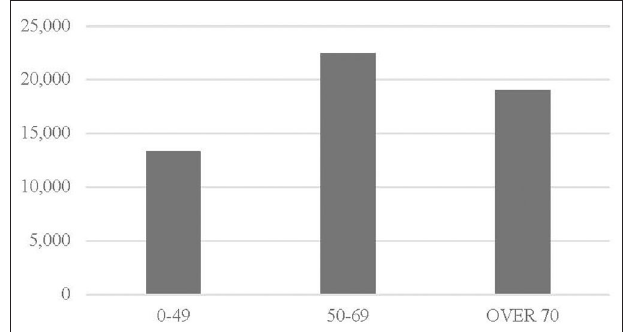
FIGURE 1 | Italian women: breast cancer by age in 2017. Source: Eurostat